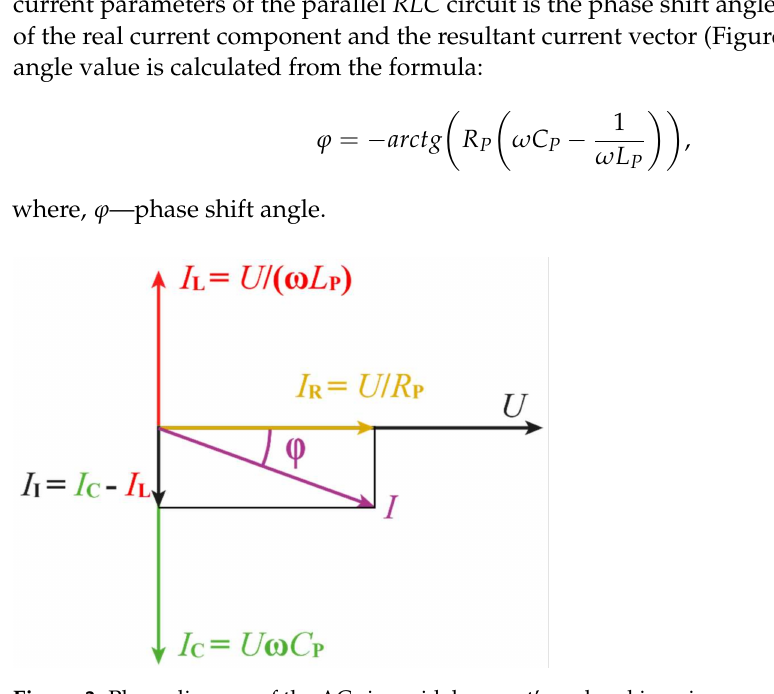
Figure 3. Phase diagram of the AC sinusoidal current’s real and imaginary components for a